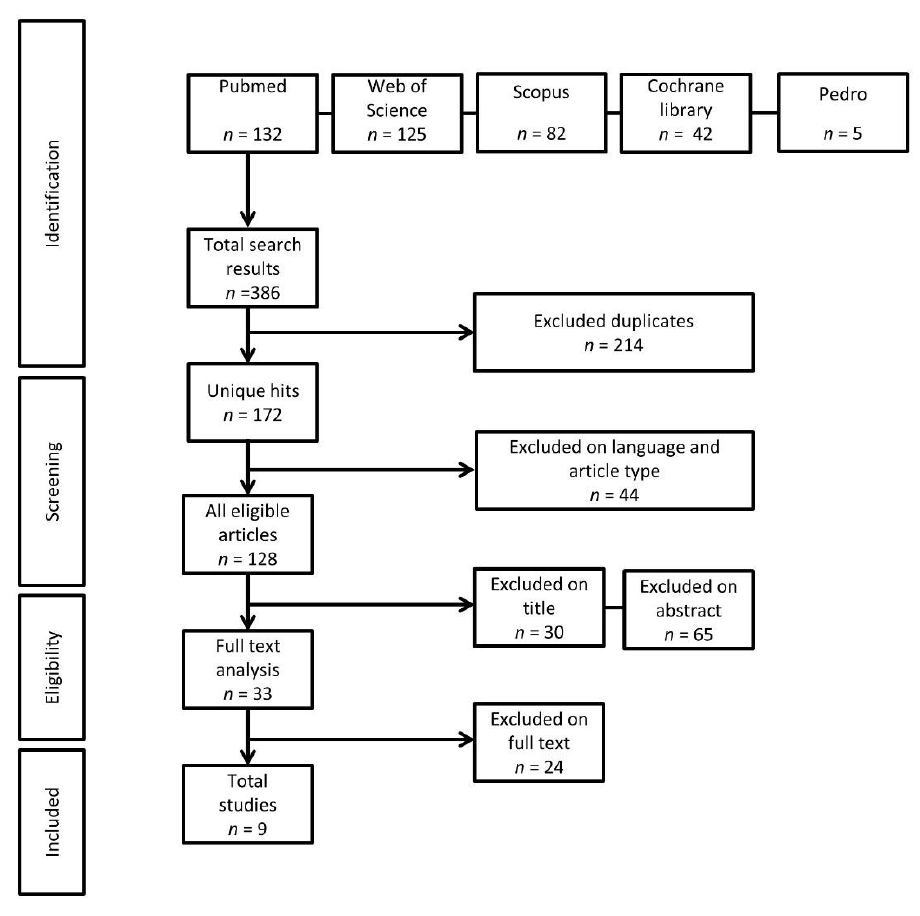
Figure 1. Flow diagram outlining the article selection steps. Table 1. Data extraction table collating the characteristics from the ( n = 9) included studies.